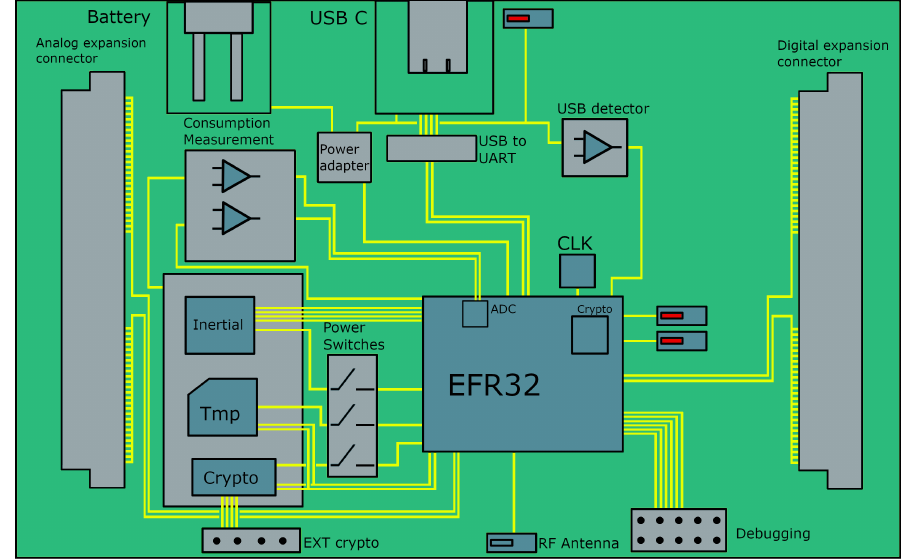
Figure 1. Block Diagram of the designed Cookie